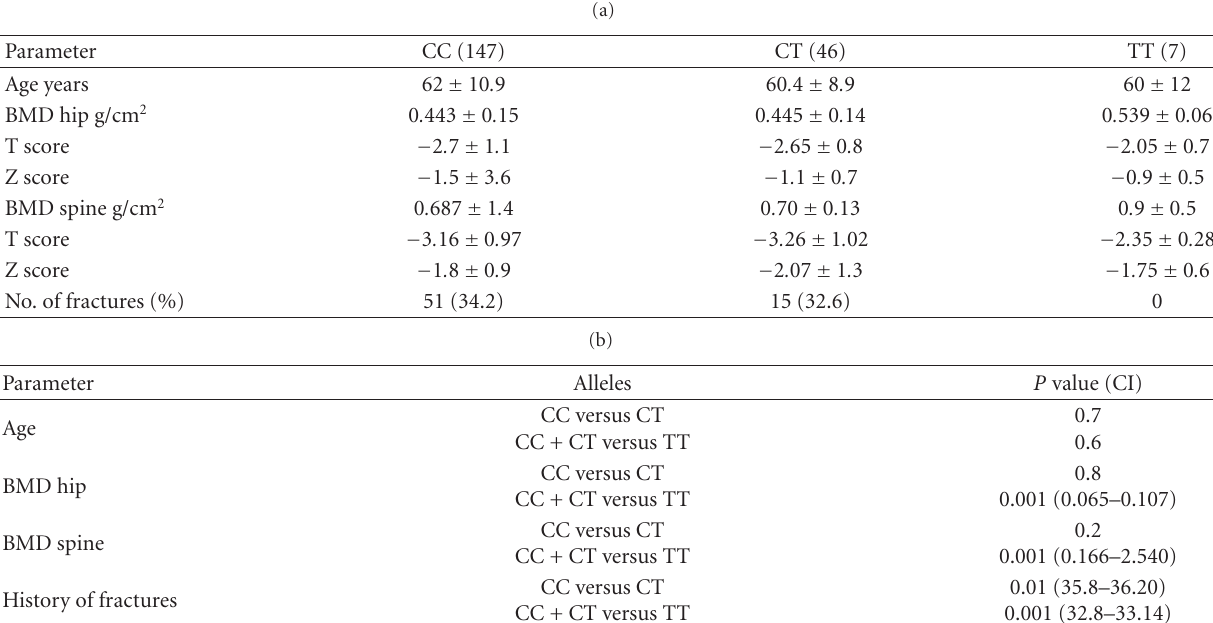
Table 2: (a) Demographic data of LRP5 (C 25752205 10) of CC, CT, and TT alleles. (b) Statistical analysis of the LRP5 (C 25752205 10) 3